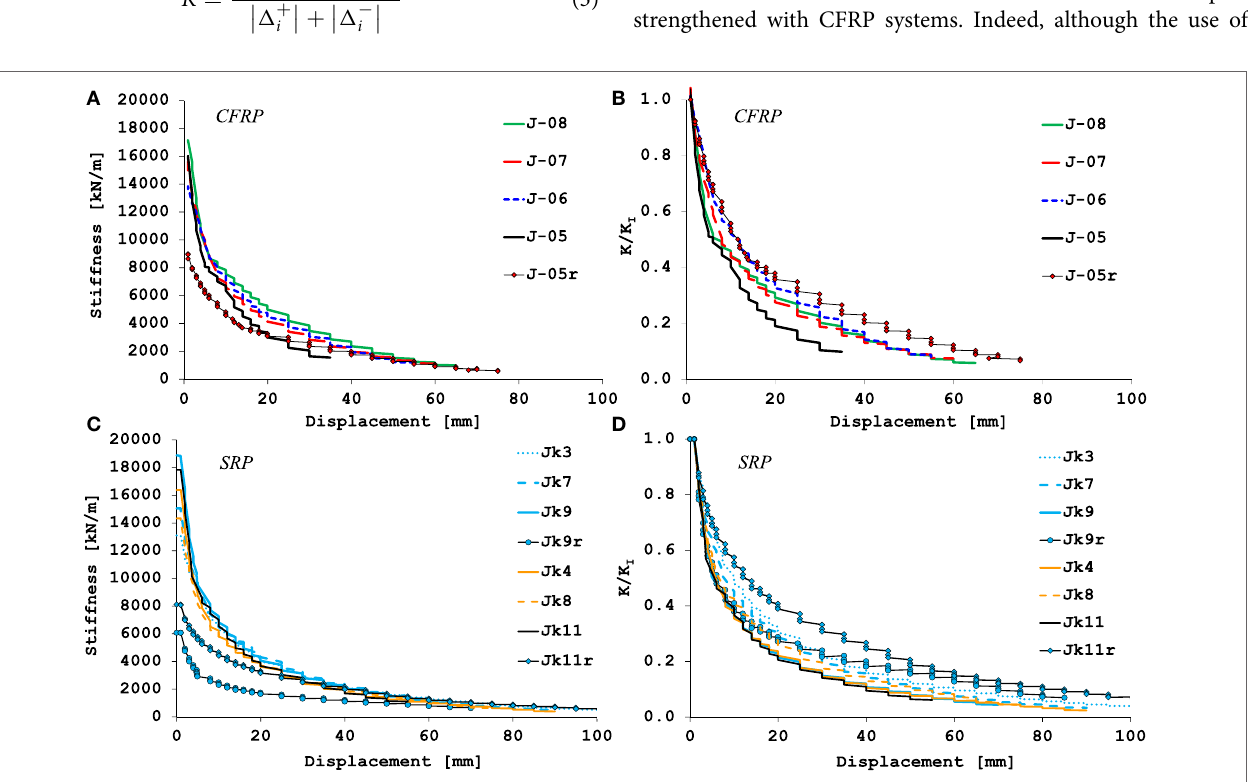
FIGURE 12 | Stiffness degradation: CFRP strengthened specimens (A,B) ; SRP strengthened specimens (C,D) .